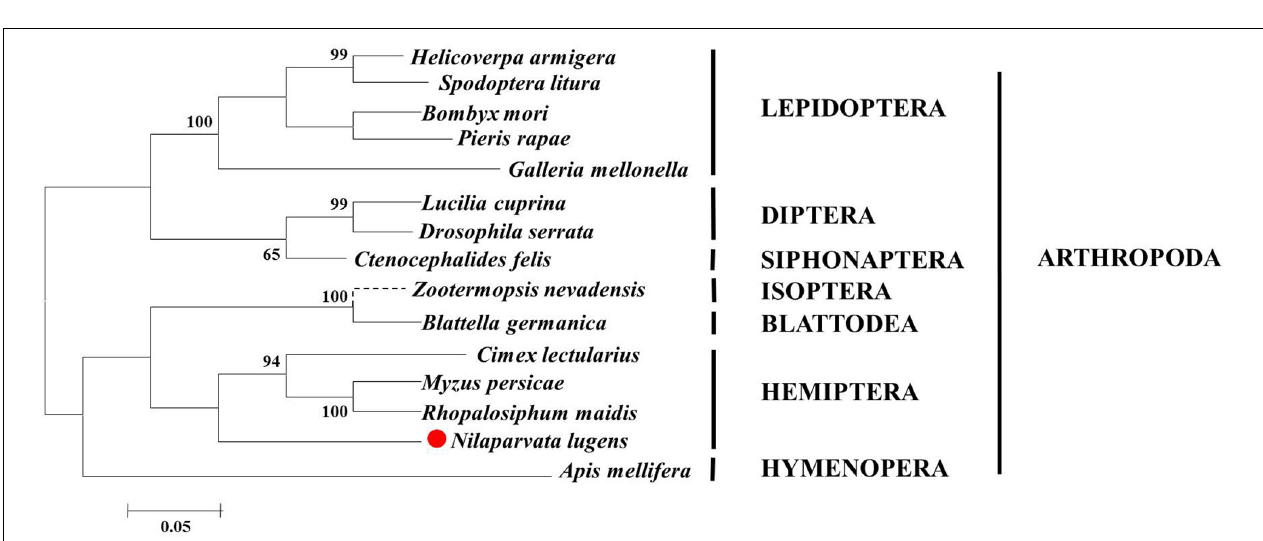
FIGURE 1 | dsRNA treatments influence nymphal BPH mortality and accumulation of mRNAs encoding NlSPF-L. (A) The histogram bars show mean BPH male and nymph mortality as proportions. The error bars indicate one SEM, n = 50, N = 3 independent biological replicates. (B) The histogram bars show mean silencing efficiency of NlSPF-L in dsRNA-treated males at 2 DAE, n = 5, N = 3 independent biological replicates (Student’s t -test). The histogram bars with different letters are significant difference at p < 0.05.